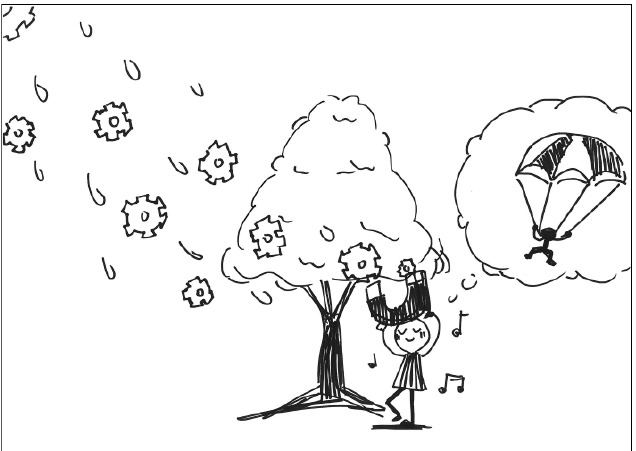
Figure 6. Work by APT Averaging Personality Traits.